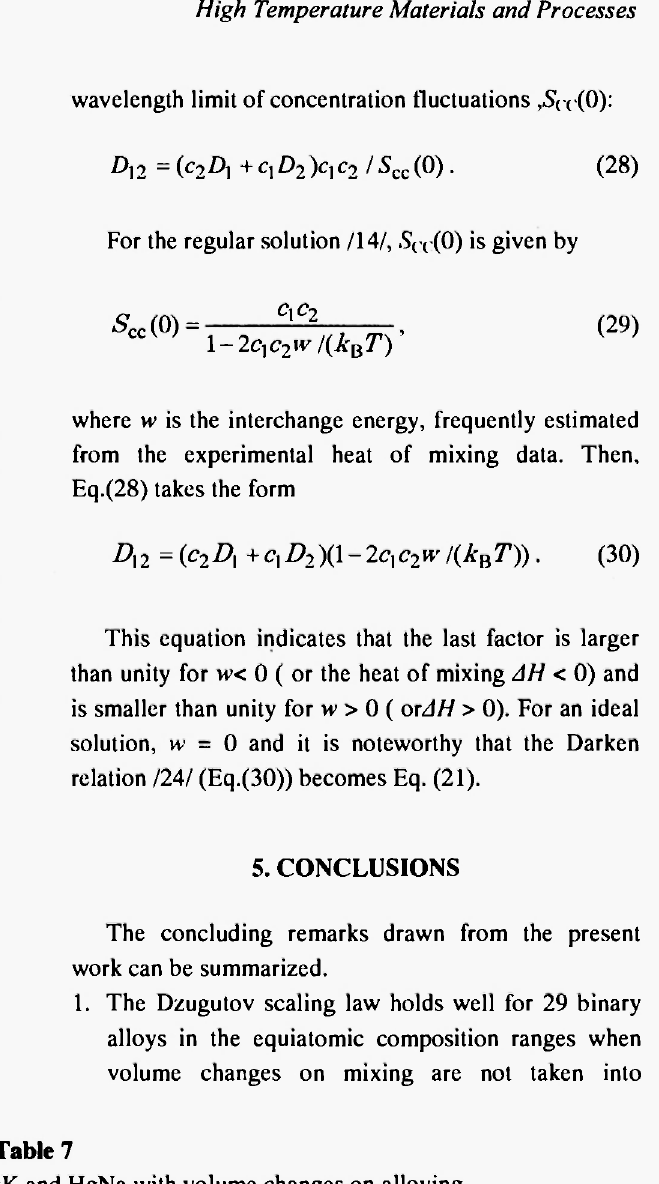
Input data of another calculation for HgK and HgNa with volume changes on alloying.